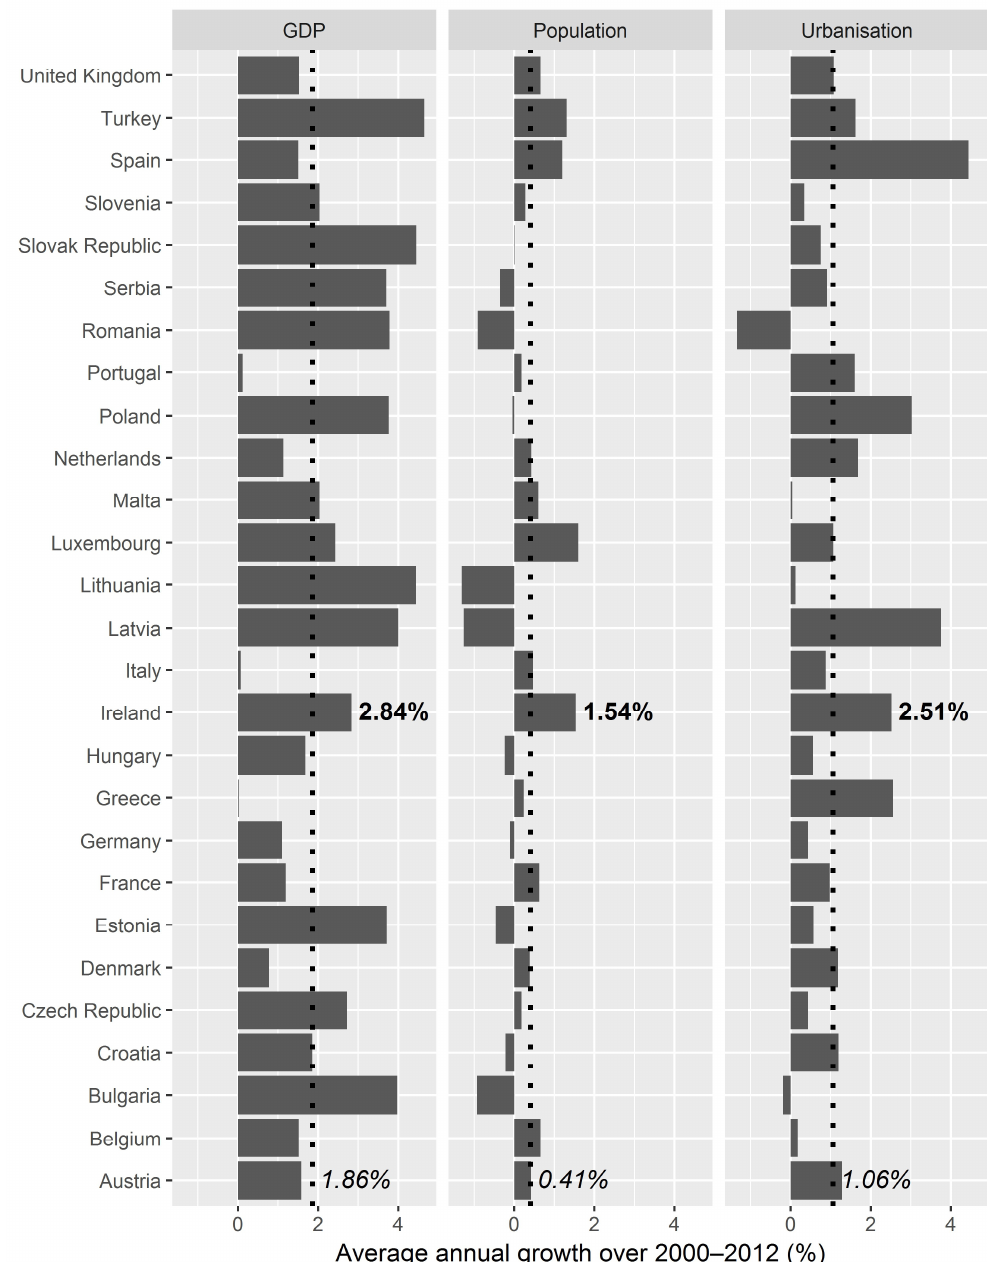
Figure 1. GDP growth, population growth and rate of urbanisation in 2000–2012. Dotted lines indicate average annual growth for all countries, excluding Ireland (average rates shown in italics). Growth rates in bold are for Ireland. ( Data source: Authors’ calculations using IMF, Corine Land Cover.).